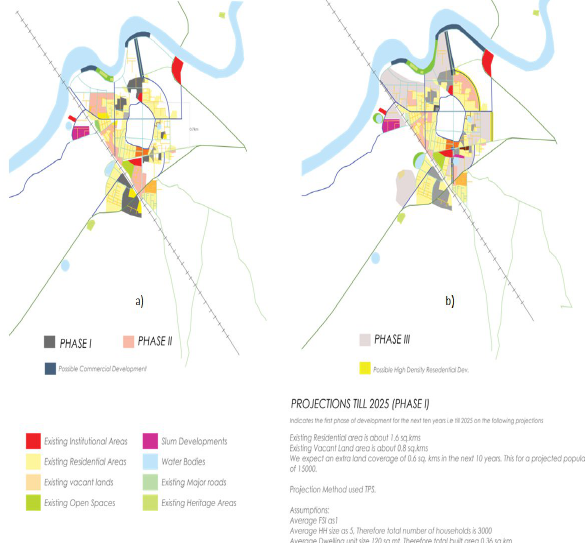
Figure 6. a) Concept maps of Phase I and II b) Concept map of